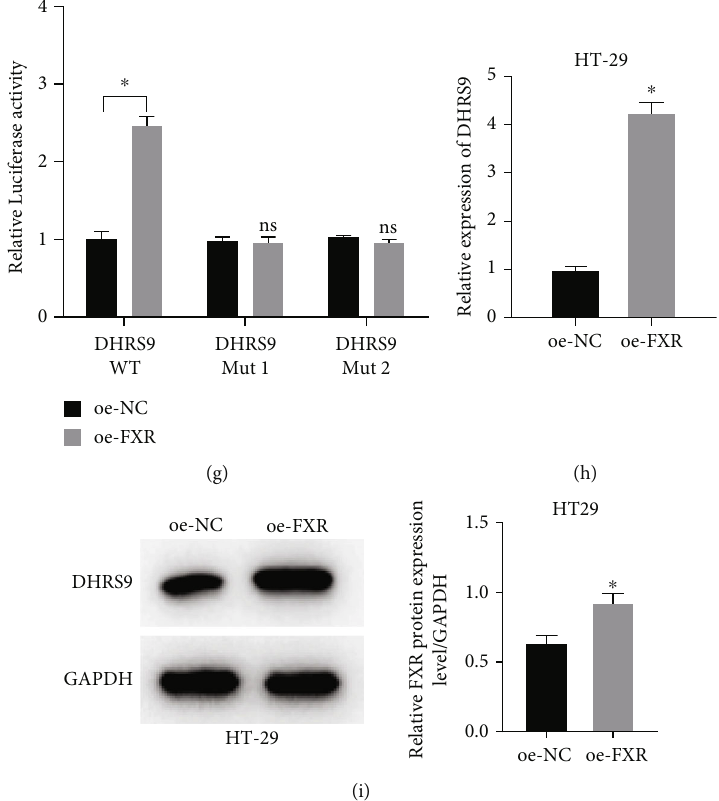
Figure 3: FXR activates DHRS9 and upregulates DHRS9 expression. (a) Venn diagram of FXR target genes predicted by MotifMap and GTRD databases. (b) Scatter chart of the Pearson correlation analysis between FXR and DHRS9 in TCGA database. (c) Boxplot of DHRS9 expression in normal and colon cancer tissues. (d) mRNA expression of DHRS9 in colon cancer cell lines measured by qRT- PCR. (e) Binding sequence of DHRS9 promoter region and FXR in JASPAR database. (f and g) Binding between FXR and DHRS9 promoter region demonstrated by ChIP and dual-luciferase assays. (h and i) E ff ect of FXR overexpression on DHRS9 expression in HT- 29 cells detected by qRT-PCR and Western blot. ( ∗ denotes P < 0 : 05